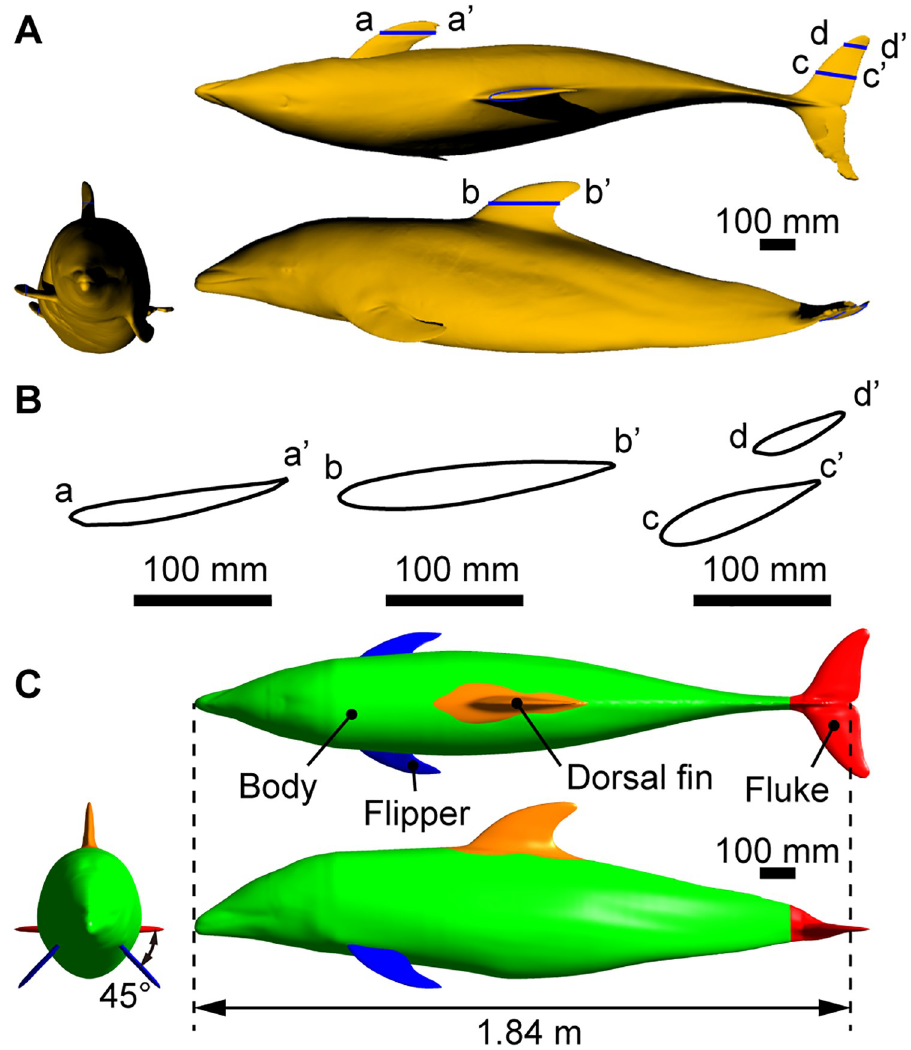
Fig 4. Dolphin models. (A) Original 3-D model of the frozen dolphin. (B) Representative cross-sectional shapes of the flippers, dorsal fin, and fluke of the original model. (C) Reconstructed symmetrical model used for the CFD simulation. The model was sectioned into four different parts: body, flippers, dorsal fin, and fluke. See also S1 and S2 Files for the models.